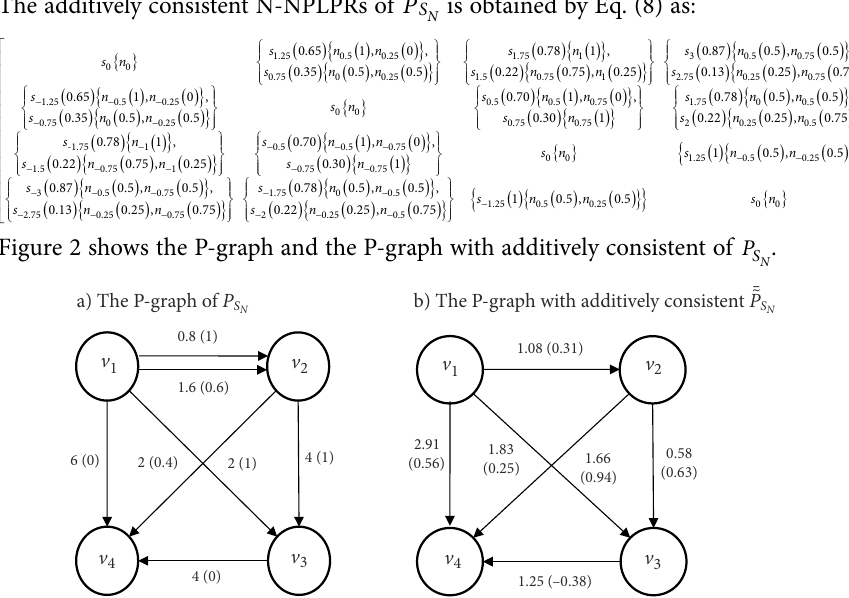
Figure 2. The P-graph of